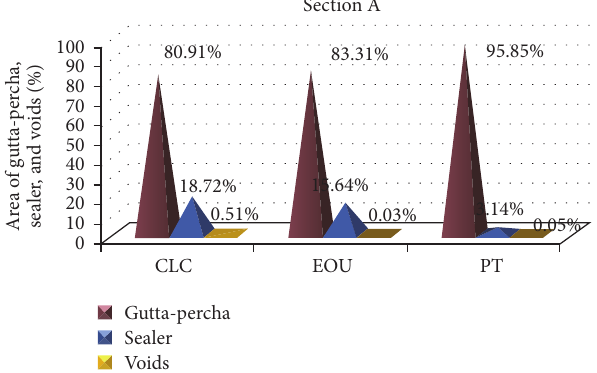
Figure 4: The percentage of the canal area filled with gutta-percha, sealer, and voids after using three gutta-percha techniques, section